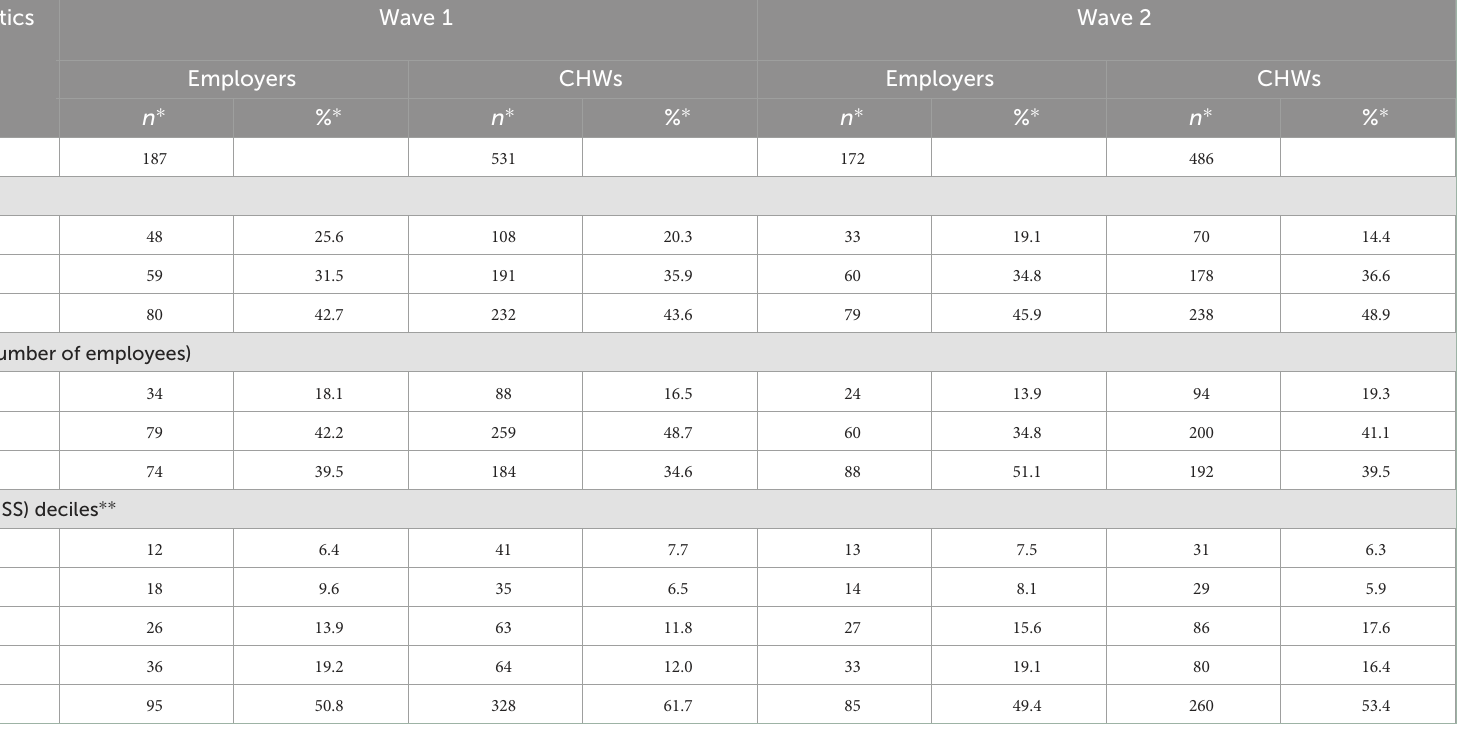
TABLE 2 Organizational characteristics of CHWs and CHW employers responding to the survey. Organizational characteristics Wave 1 Wave 2 of survey respondents Employers CHWs Employers